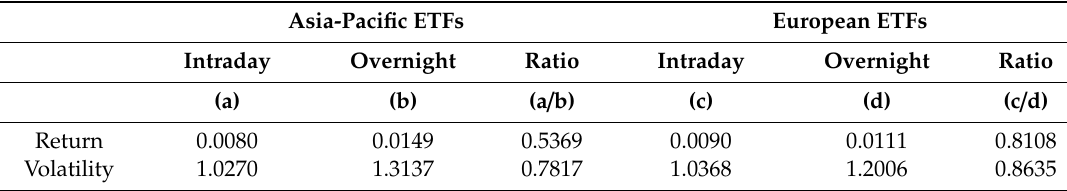
Table 3. Intraday and overnight return and risk